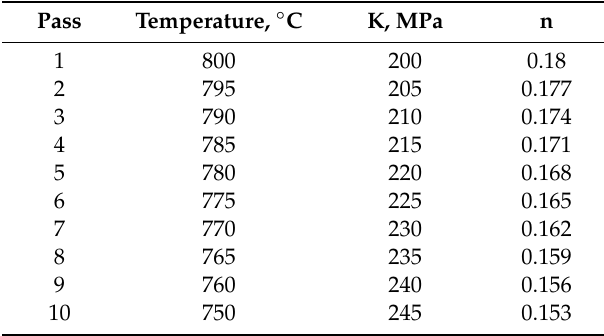
Table 2. Rolling parameters for ten